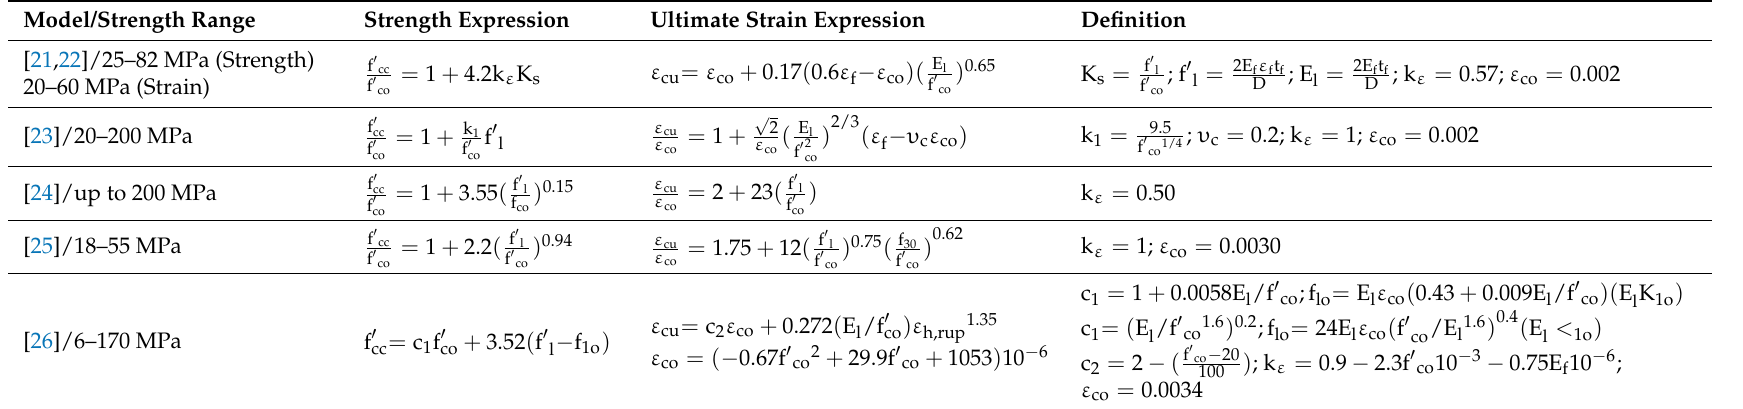
Table 5. Axial Strength and Ultimate Strain Prediction Expressions of Investigated